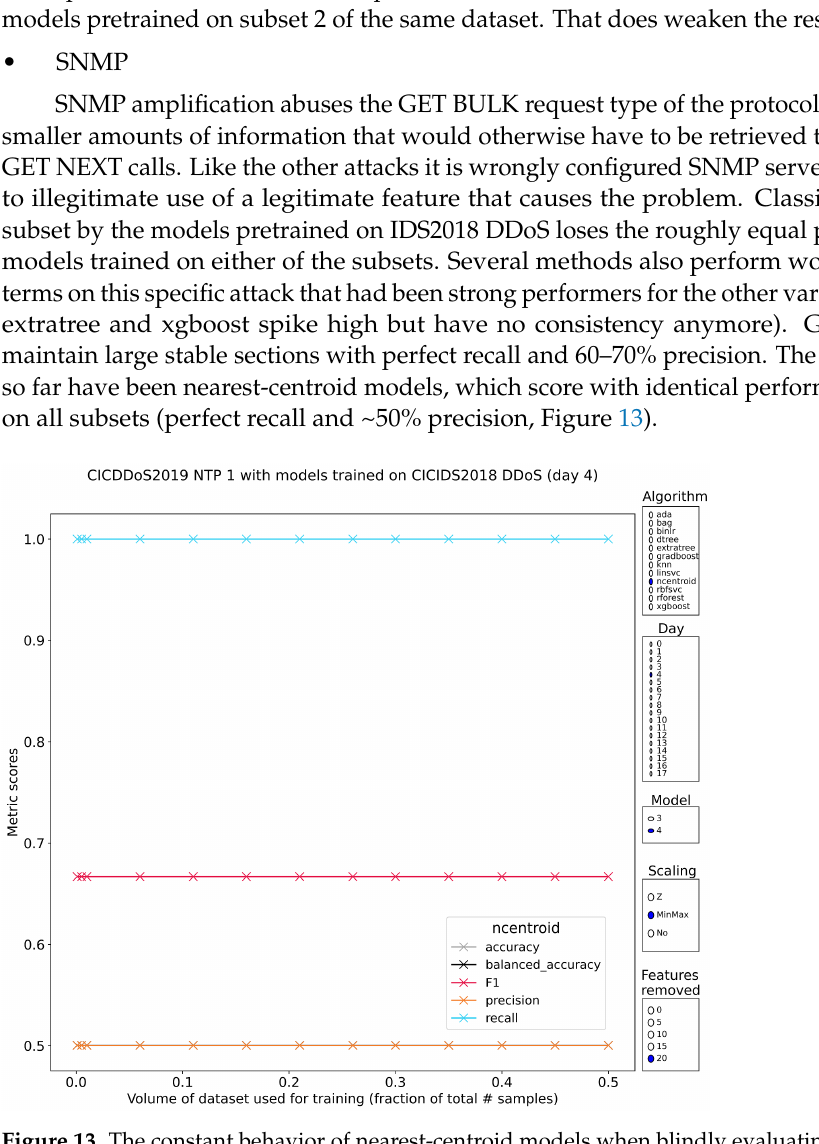
Figure 13. The constant behavior of nearest-centroid models when blindly evaluating DDoS samples from CIC-DDoS-2019. The method maintains perfect recall, but precision is heavily affected, falling back to a mere